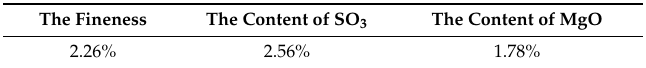
Table 2. Physical properties and chemical composition of the cement.